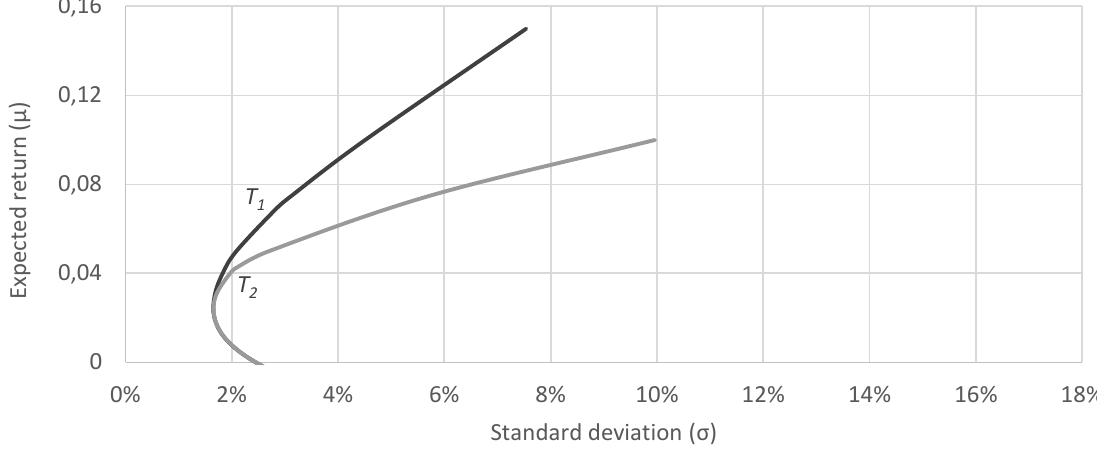
Figure 3. Efficient frontiers with and without the cryptocurrency market